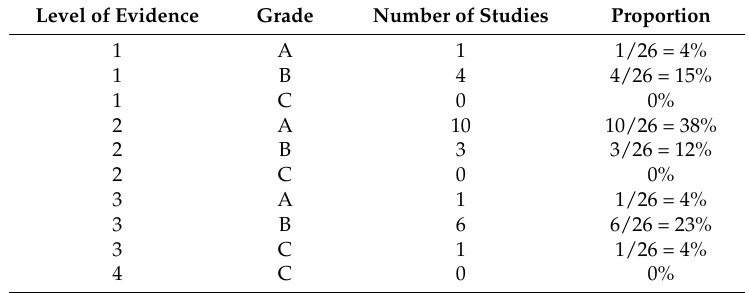
Table 3. Proportion of studies included in systematic review according to level and grade of evidence.